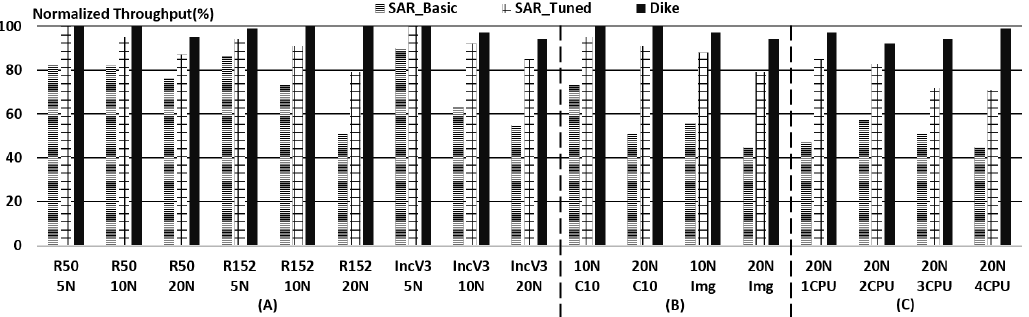
Figure 4. Performance comparison on different models/scale/heterogeneity. The X -axis is the different experiment setups where R , IncV 3, N , C 10, and Img are short for Resnet, Inception-V3, Node, Cifar10, and Imagenetl respectively. Y -axis is the normalized throughput. The value 100% indicates same performance as iterative approach.